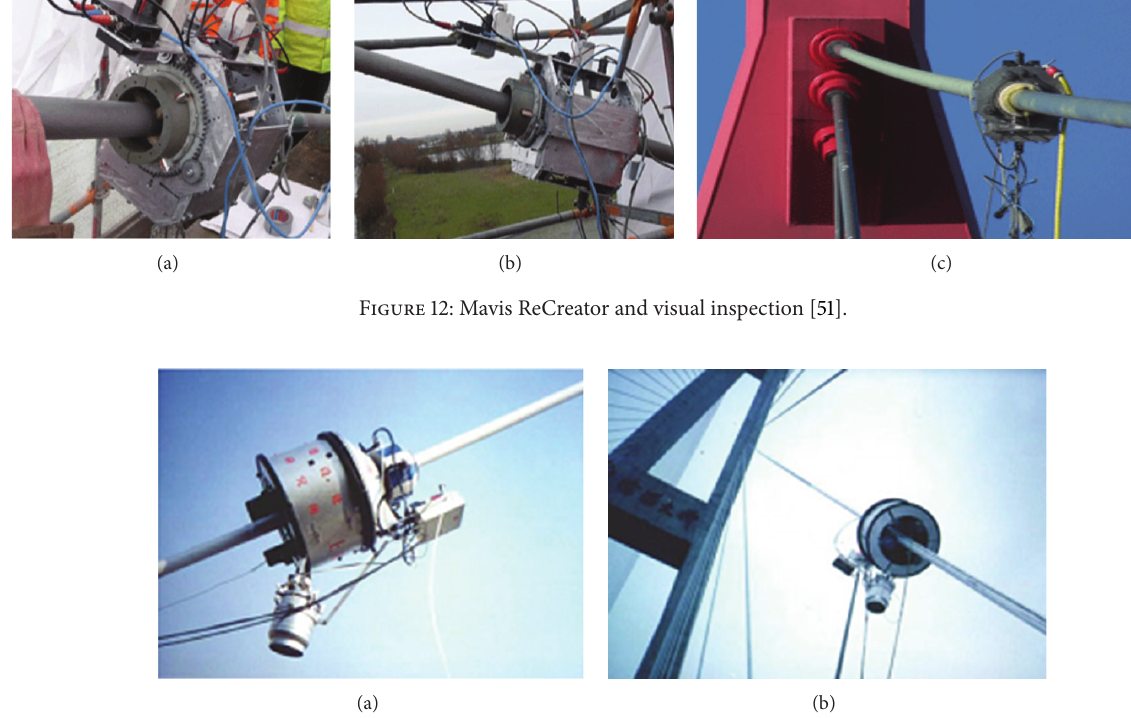
Figure 13: In situ painting experiment of cable maintenance robot